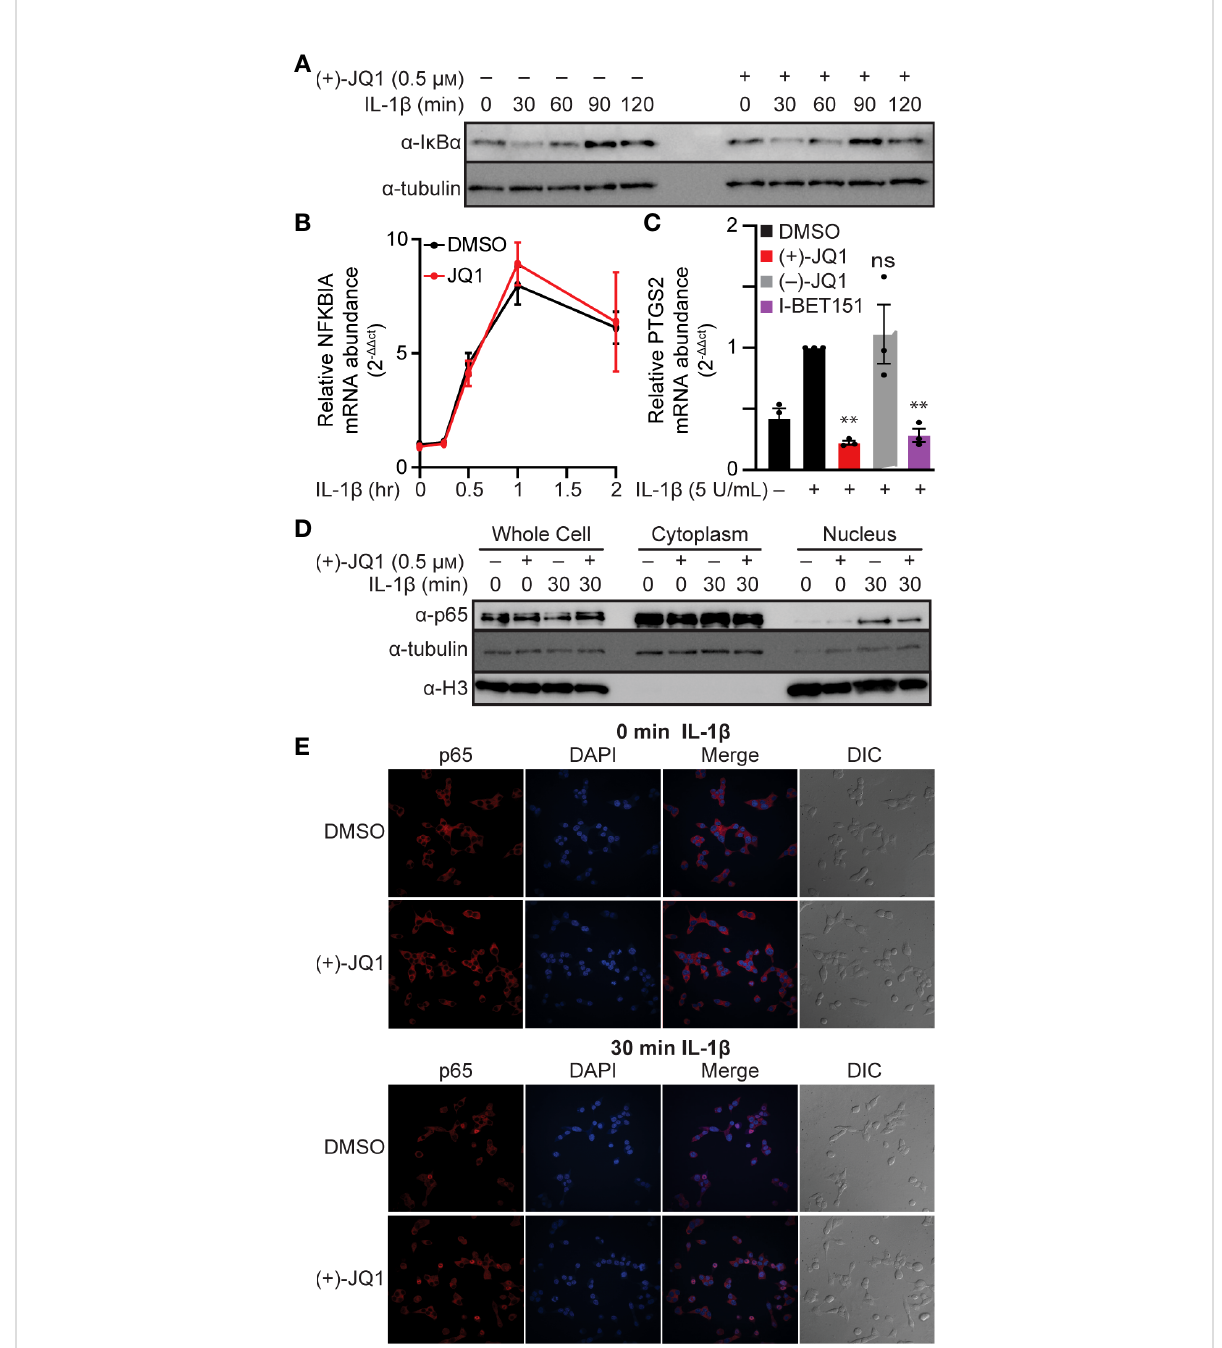
FIGURE 2 BET bromodomain inhibitors act by inhibiting transcriptional activation of select NF- k B gene targets. (A) Immunoblot using an antibody directed towards the I k B a protein in INS 832/13 cells treated for 1 hour with 0.5 m M (+)-JQ1 or DMSO followed by 5 U/mL IL-1 b for up to 120 minutes. (B) RT-qPCR analysis of NFKBIA in INS 832/13 cells treated for 1 hour with 0.5 m M (+)-JQ1 or DMSO followed by 5 U/mL IL-1 b for up to 2 hours. (C) RT-qPCR analysis of PTGS2 in INS832/13 cells treated for 1 hour with 0.5 m M (+)-JQ1, 0.5 m M ( – )-JQ1, 1 m M I-BET151, or DMSO followed by addition of 5 U/mL IL-1 b for 3 hours. (D) Immunoblot analysis in INS 832/13 subcellular fractions using antibodies directed against p65 or a -tubulin or histone H3 loading controls after 1-hour pre-treatment with 0.5 m M (+)-JQ1 or DMSO followed by the indicated 0- or 30- minute exposure to 5 U/mL IL-1 b . (E) Immunocytochemistry analysis of p65 in INS 832/13 cells upon 1-hour pre-treatment with 0.5 m M (+)-JQ1 or DMSO followed by 0- or 30-minute exposure to 5 U/mL IL-1 b . Immunoblots are representative of two independent biological replicates. All error bars for RT-qPCR represent the standard error of the mean (SEM) from 3 independent biological replicates. Signi fi cance was determined by ANOVA followed by Dunnett ’ s multiple comparisons test, *< 0.05, **< 0.01, ***< 0.005, and ns >